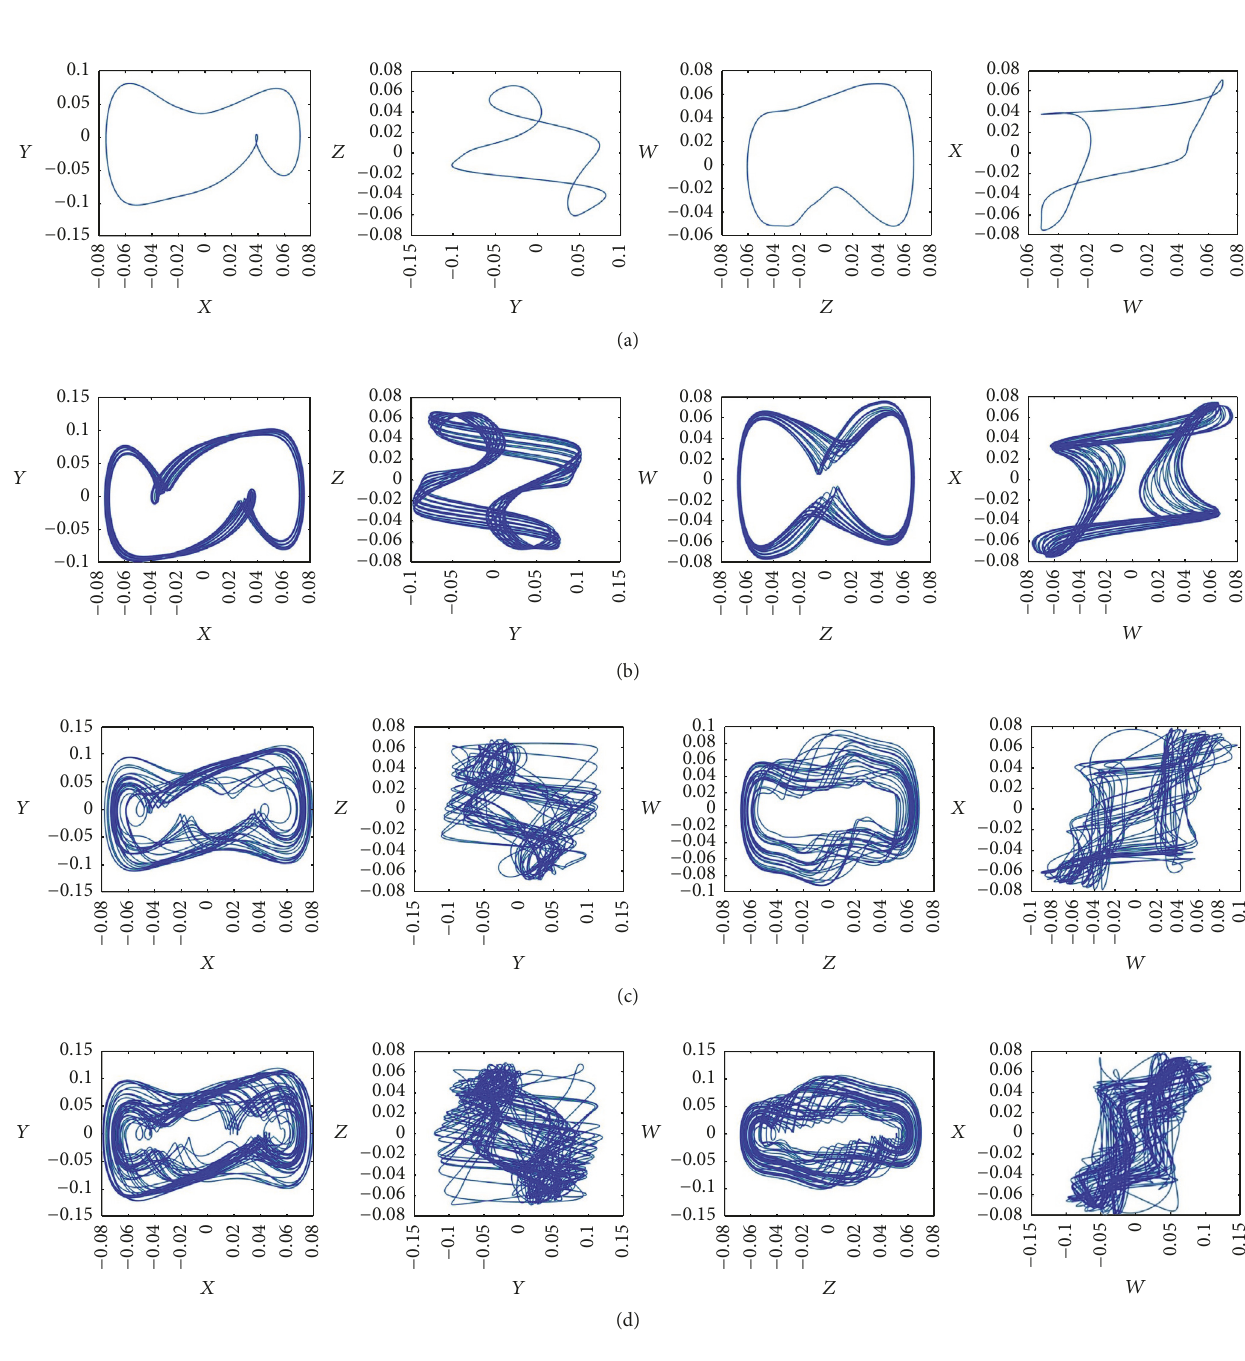
Figure 4: 2D phase portraits of the FO2DOFSMA oscillator: (a) periodic; (b) quasiperiodic; (c) chaotic; (d)